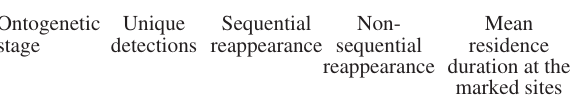
Table 1. – descriptive residence characteristics for the shoals of the three ontogenetic stages and mean shoal residence at the sites ontogenetic unique